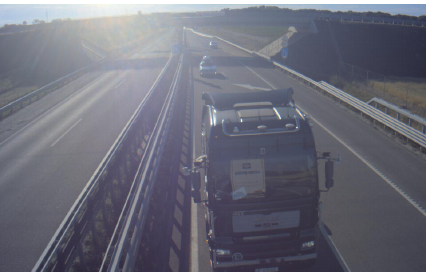
Figure 11. Example image taken from Infra2 station, facing the overpass.